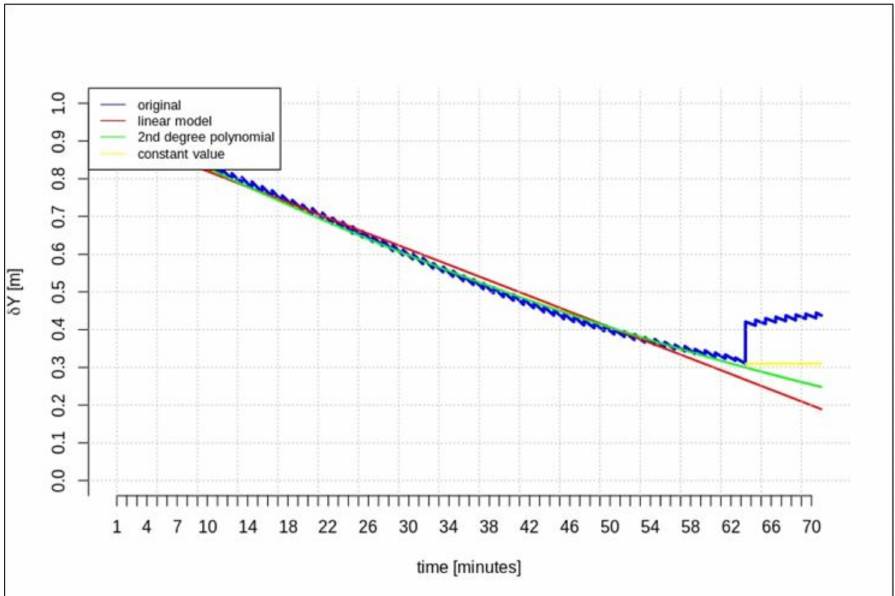
Figure 6. The results of the δ Y geocentric correction extrapolation (GPS G13) for a 70 min data-stream—the time series of the orbit corrections refer to an out-of-date navigation